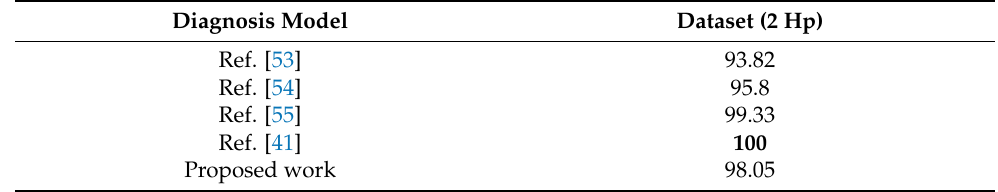
Table 16. Comparison with published in literature for bearing fault diagnosis models in normal condition.